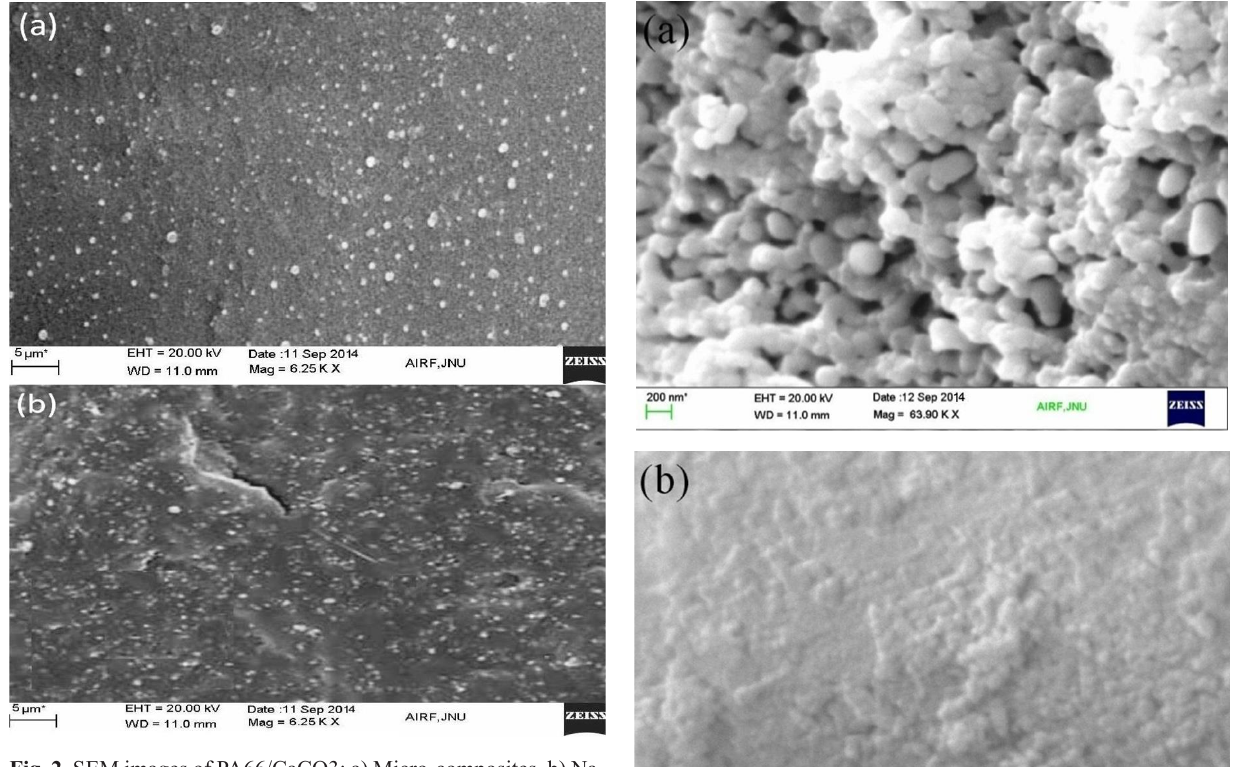
: a) Micro-composites, b) Na- 3